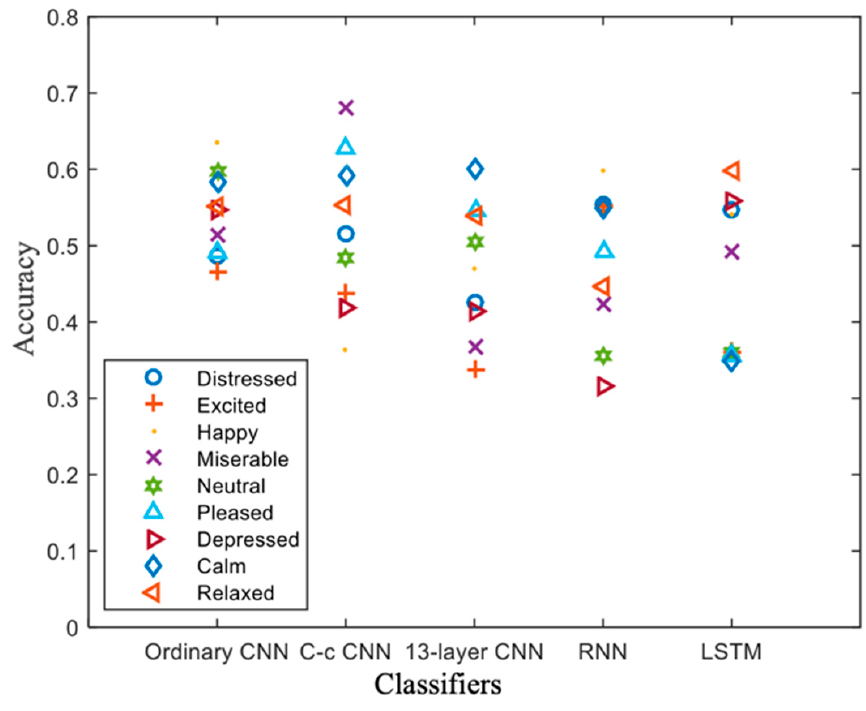
Figure 6. Feature separation scatter diagram.